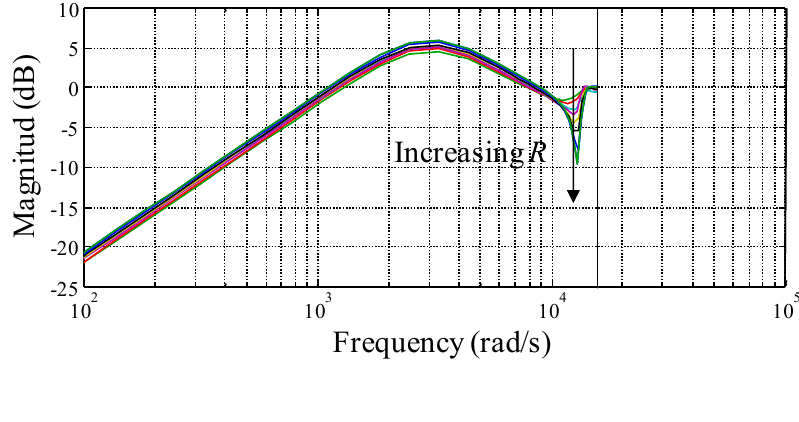
Figure 8. Bode magnitude diagram of S operating